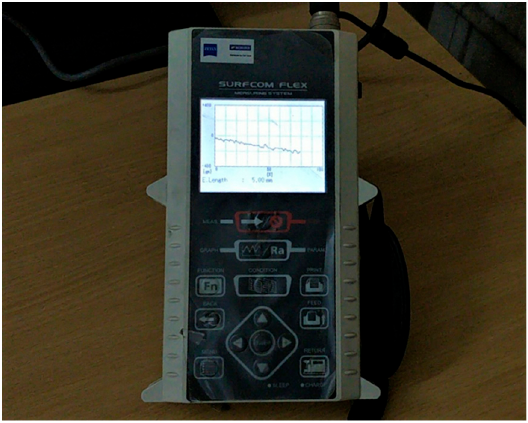
Figure 2. Turning operation: ( a ) schematic diagram; ( b ) experimental setup.